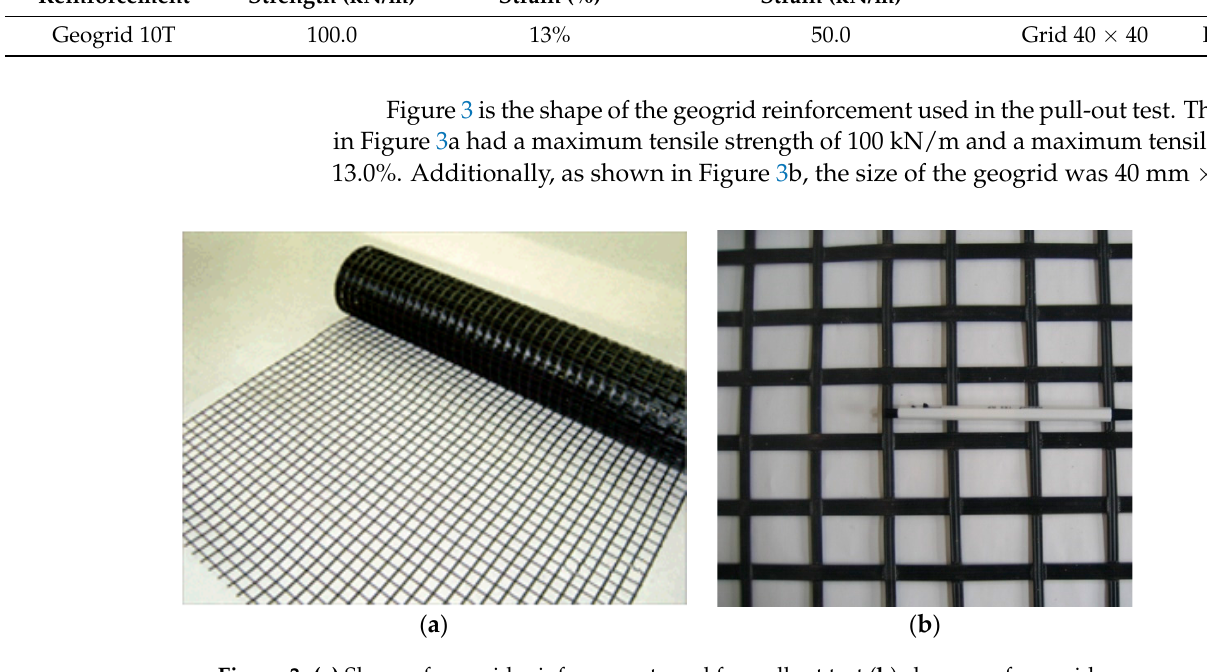
Table 1. Physical properties of reinforcement used for test.